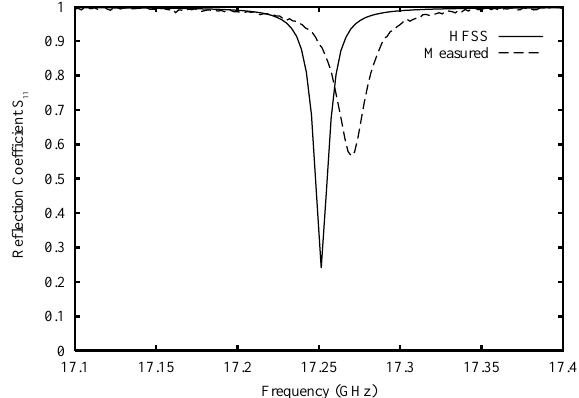
FIG. 4. Vertex coupling scheme with six rods removed: fre- quency dependence of the measured reflectivity, S 11 (dotted line) and HFSS simulations (solid line).